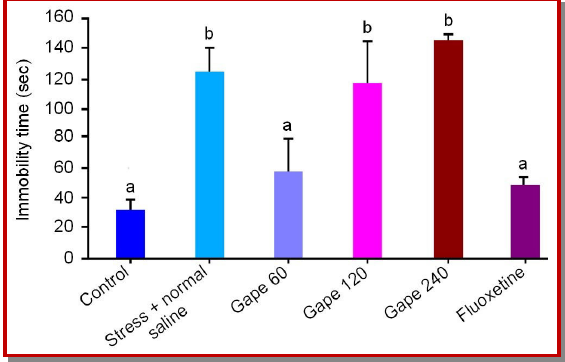
Figure 2: The effect of intraperitoneal injection of fluoxetine and different doses of grape seed oil on immobility time in forced swimming test; difference is considered significant at p<0.05